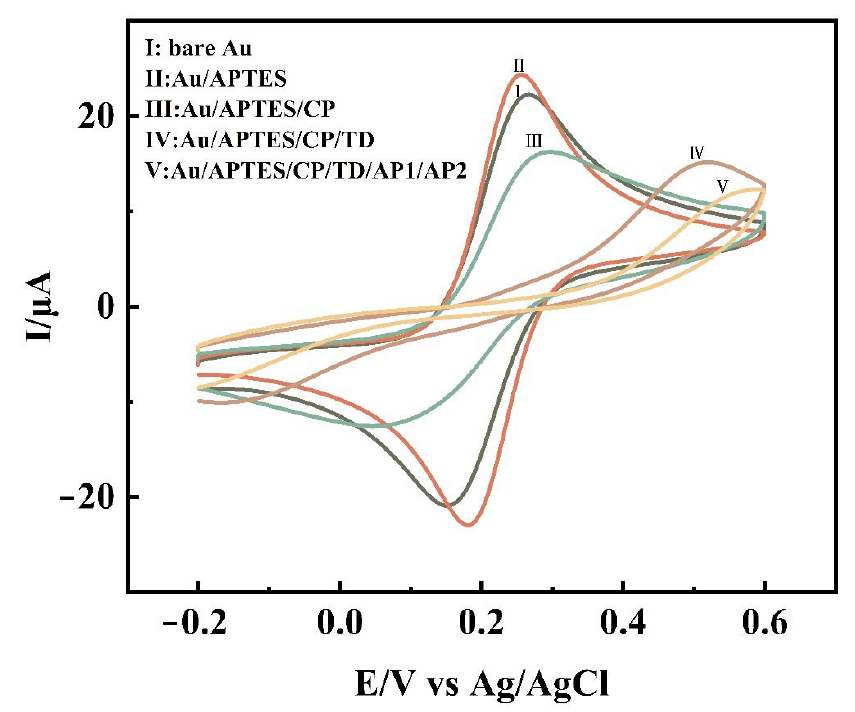
Figure 2. CV at bare Au(I), Au/APTES(II), Au/APTES/CP(III), Au/APTES/CP/TD(IV), and Au/APTES/CP/TD/AP1/AP2(V) in 0.1 mol/L KCl solution containing 5 mmol/L [Fe(CN) 6 ] 3 − /4 − .